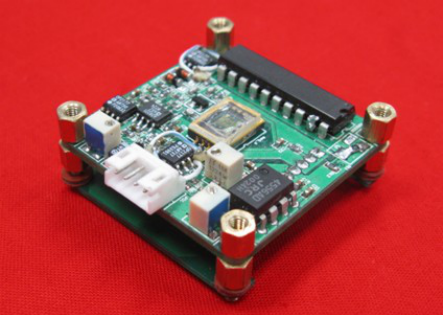
Figure 6. Integrated driving circuit and signal conditioning circuit of the MEMS torsional resonant magnetometer.